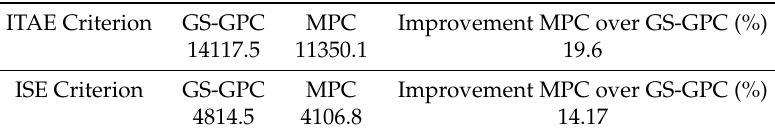
Table 3. Simulation 2: Performance comparison using ITAE and ISE criteria for the comparison between the GS-GPC and the